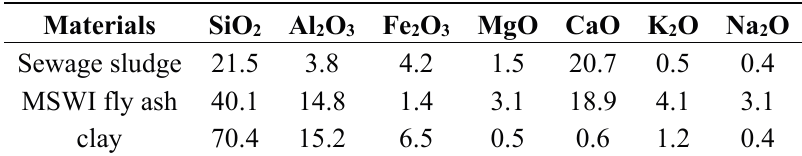
Table 1. Chemical composition of dried sewage sludge, MSWI fly ash and clay (dry weight basis).